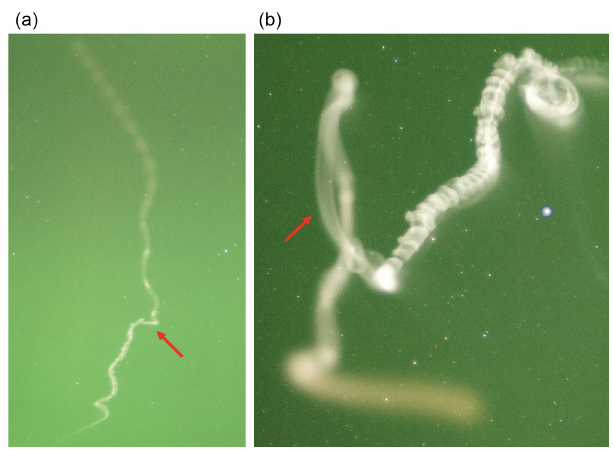
Figure 17. Photographs of the MIST-1 upleg trail from Toolik Lake (a) and Poker Flat (b) at 09:16:59UT. The 110km region is located where the trail is marked by the arrows.